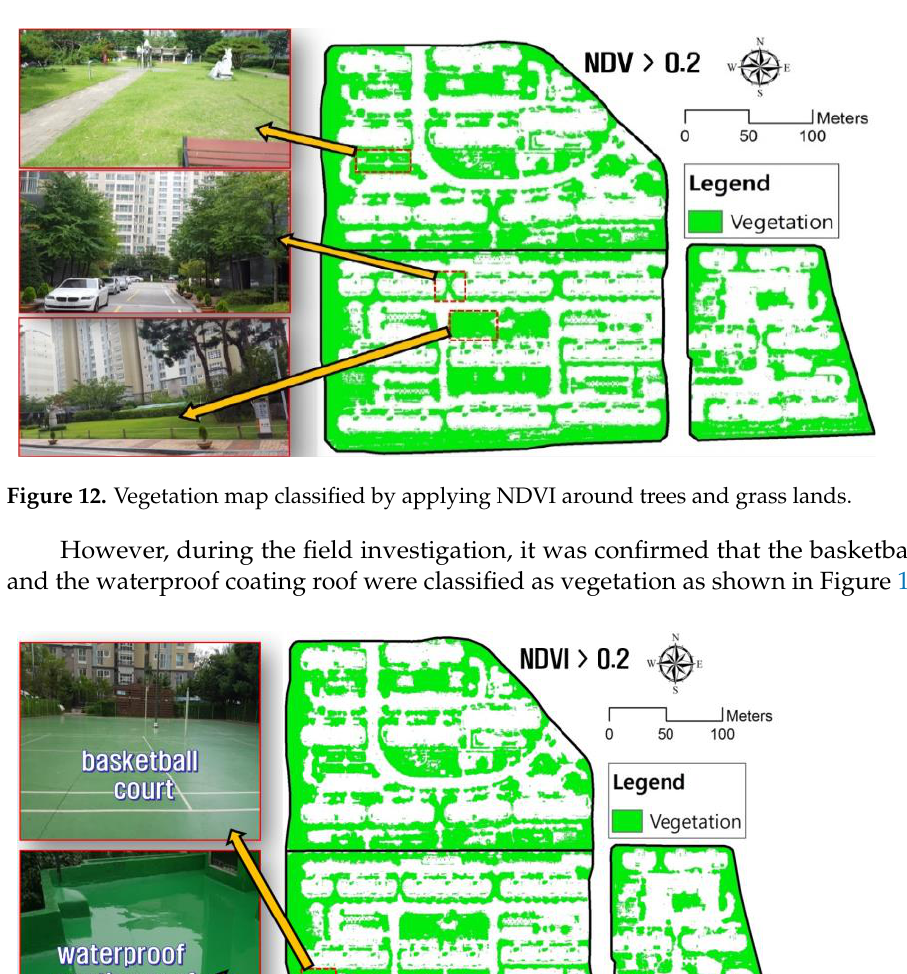
Figure 13. Vegetation map classified by applying NDVI around basketball court and waterproof coating roof.